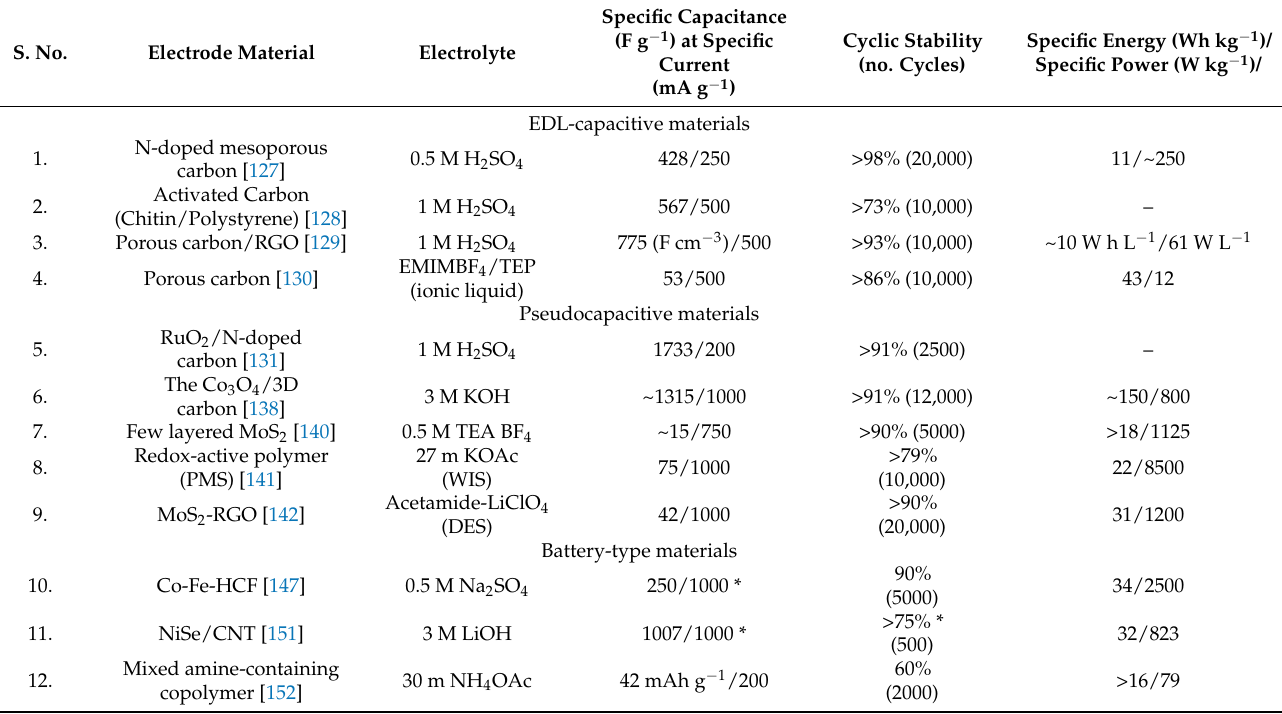
Table 1. Representative examples of various electrode materials and their electrochemical